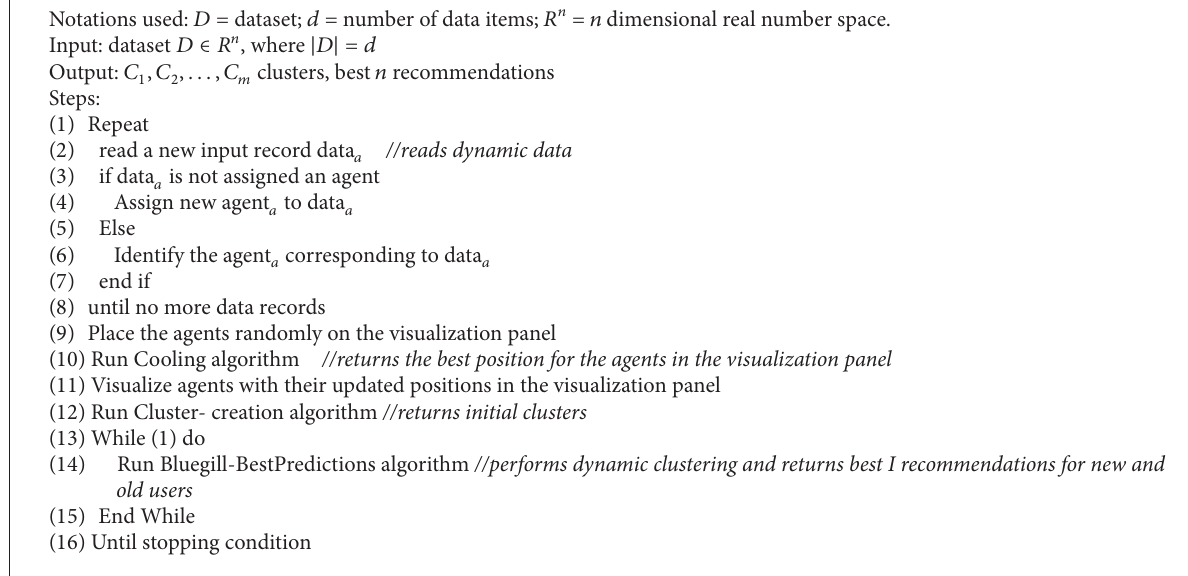
Algorithm 1: WebBluegillRecom-annealing algorithm.